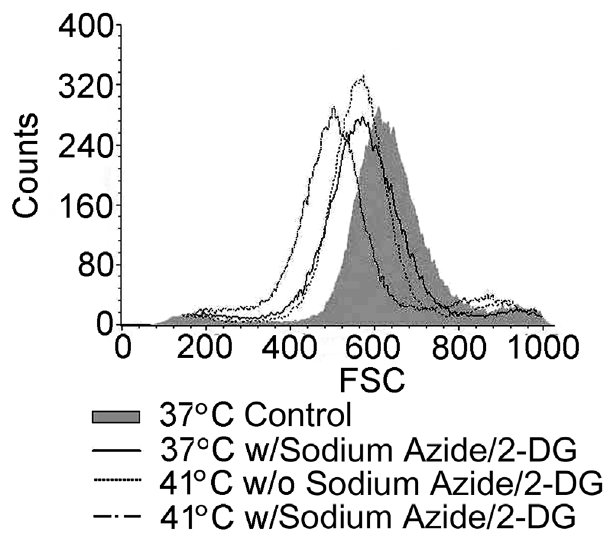
Figure 2. Temperature increase worsened sodium azide/2-DG induced reduction of cellular volume. Cells received different treatments for 1 hour, and then cell volume was measured by BD FACScan flow cytometer with an aid of Cell Quest Pro. The data were acquired using FCS with voltage E00. A total of 50,000 cells were analyzed per sample. Flow cytometry analysis showed smaller forward scatter value following the treatment with sodium azide/2-DG or increased temperature alone. Combination treatment of sodium azide/ 2-DG and increased temperature produced addictive actions in the decrease of forward scatter value. Data were representative of one of three independent experiments. w/: with; w/o: without.